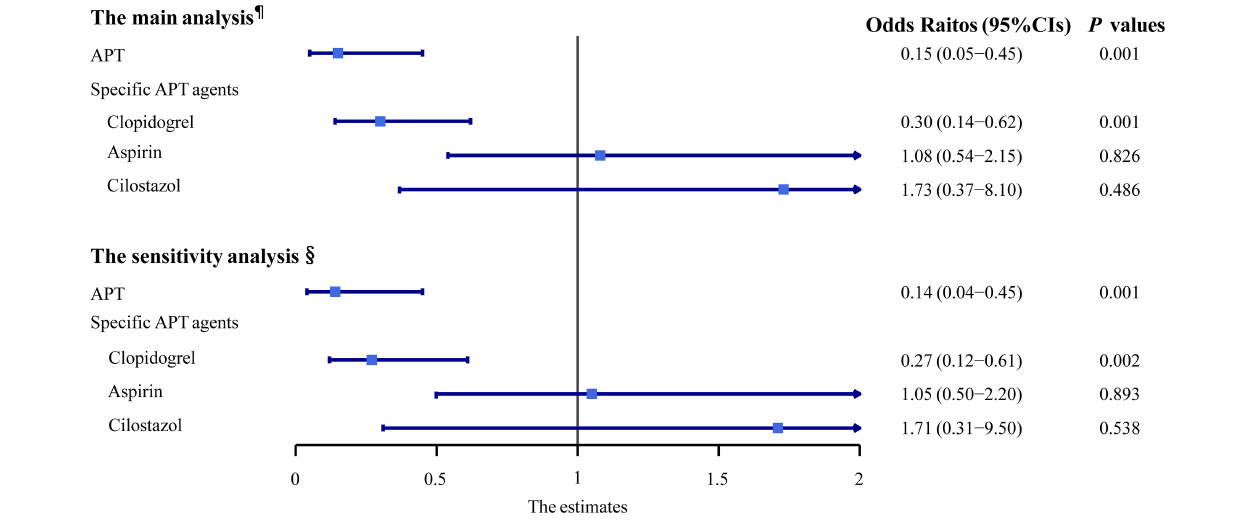
FIGURE 2 | Multivariable-adjusted conditional logistic regression analyses of the association between the anti-platelet therapy and dementia. ¶ Adjusted odds ratios ( OR s) and their 95% CI s were from the conditional logistic regression model with the adjustment of CSVD burden scores (0–5 score based on MRI assessment of lacunes, WMH, EPVS, and brain atrophy) and other confounders. § Adjusted OR s and their 95% CI s were from the conditional logistic regression model with the adjustment of four CSVD markers (lacune ≥ 1, moderate-to-severe WMH, EPVS ≥ 10, and brain atrophy) and other confounders. APT, anti-platelet therapy; CI, confidence